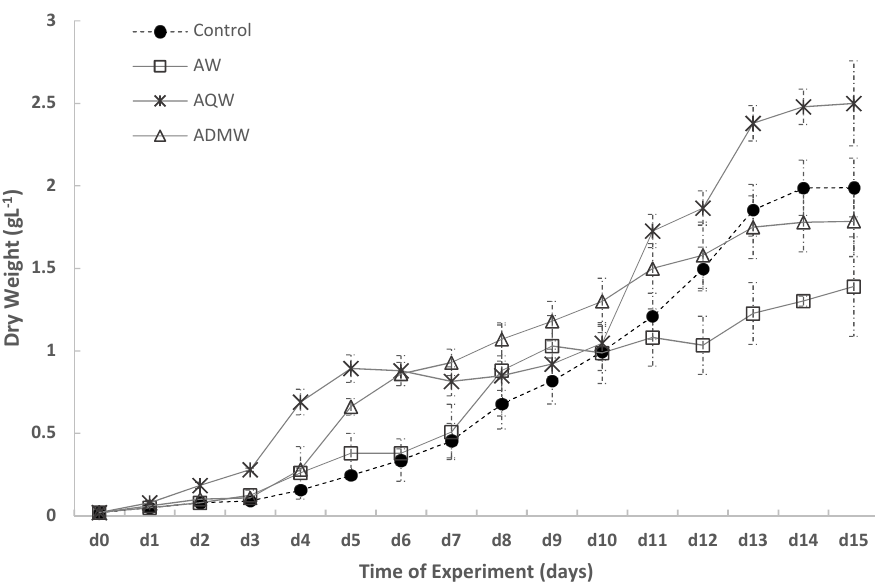
Figure 3. Dry weight of N. oceanica (in g L − 1 ) growing on control medium F / 2; AW: Agricultural Waste; AQW: Aquaculture Waste; ADMW: Anaerobically Digested Municipal Waste. Error bars represent